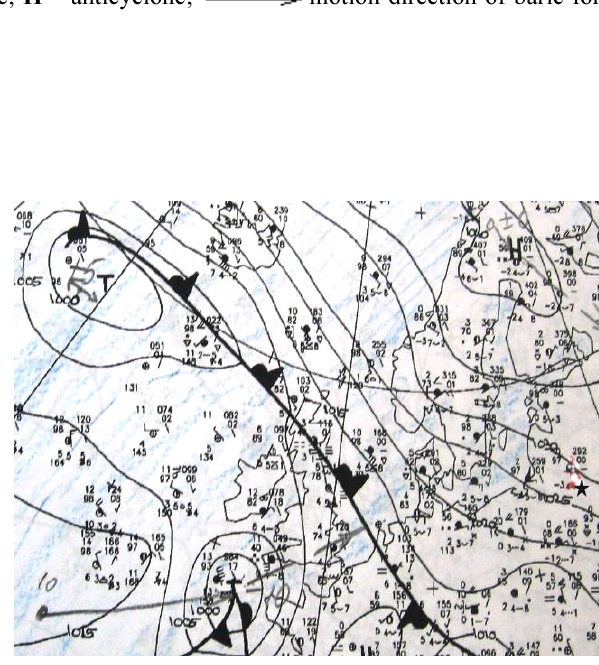
Fig. 2. 12 Oct. 2002 14 h. Time interval 12–13 hours Fig. 3. 13 Oct. 2002 14 h. Time interval 11–12 hours